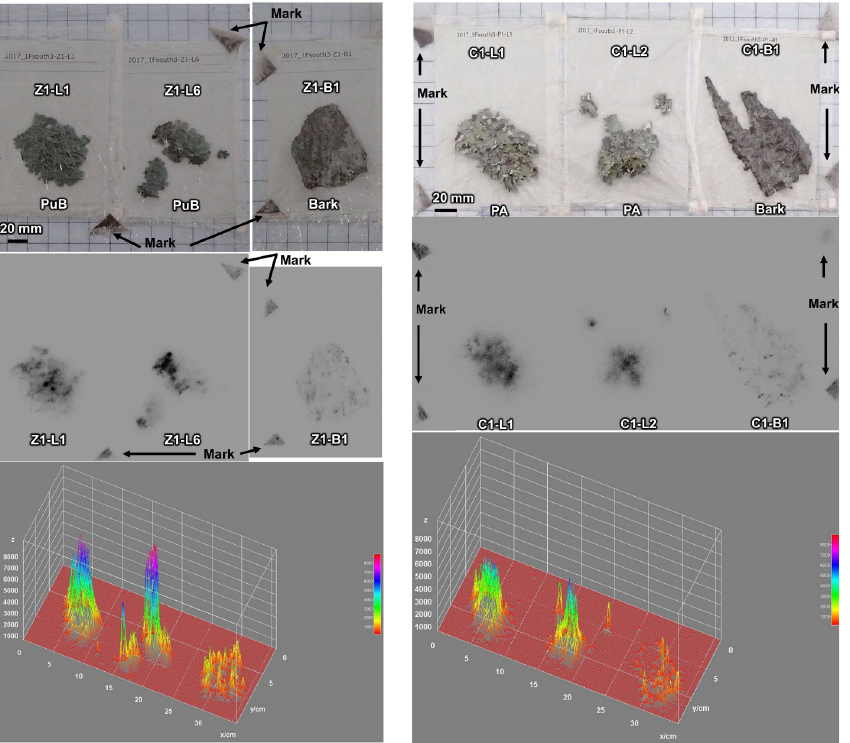
Fig 5. Autoradiograph images of lichen and bark samples. (A) Zelkova serrata . (B) Cerasus sp. PuB, Punctelia borreri ; PA, Parmotrema austrosinense .